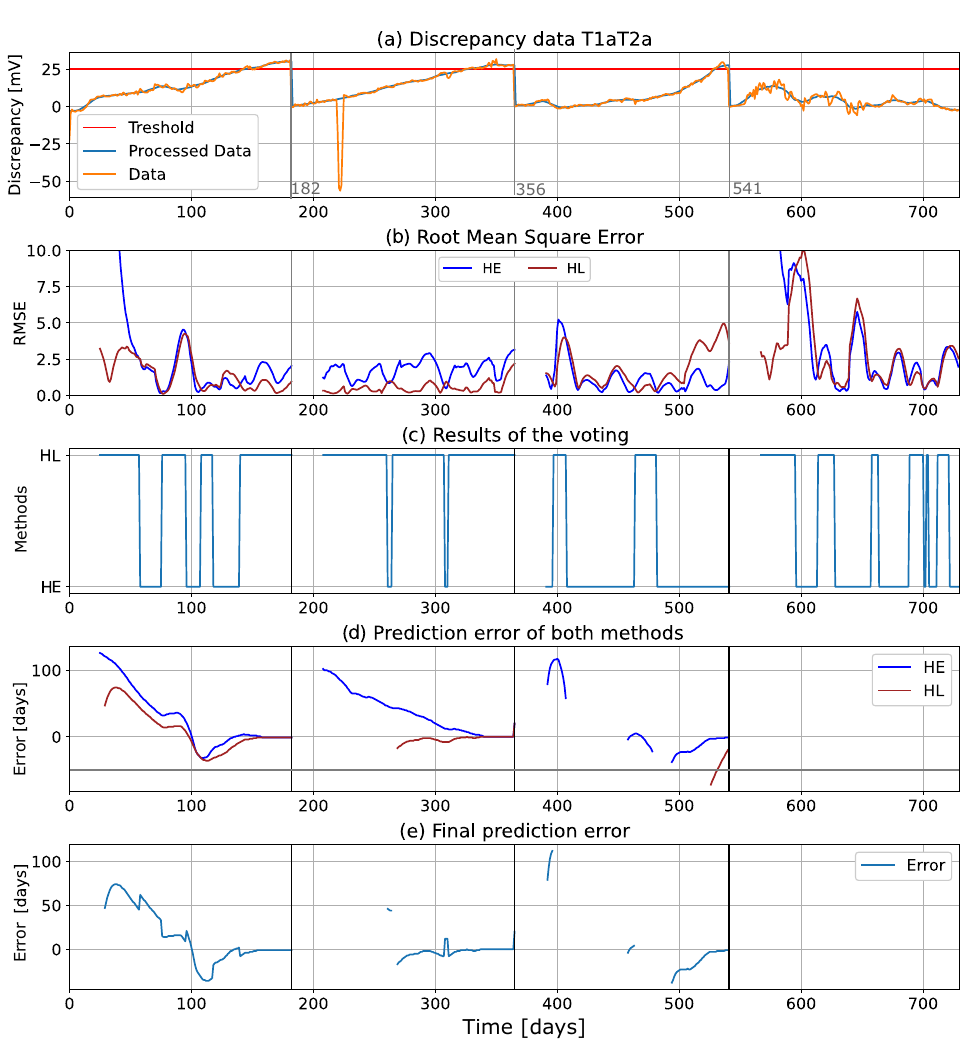
Figure 12. Example of the algorithm’s calculations for data record “T1aT2a”: ( a ) discrepancy data with threshold, ( b ) RMSE values for holdout values, ( c ) results of the voting, ( d ) prediction errors of both methods, and ( e ) final results of the algorithm based on the